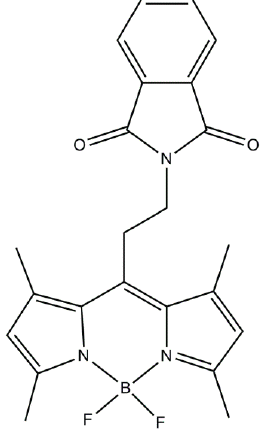
Figure 6. Chemical structure of Product 2